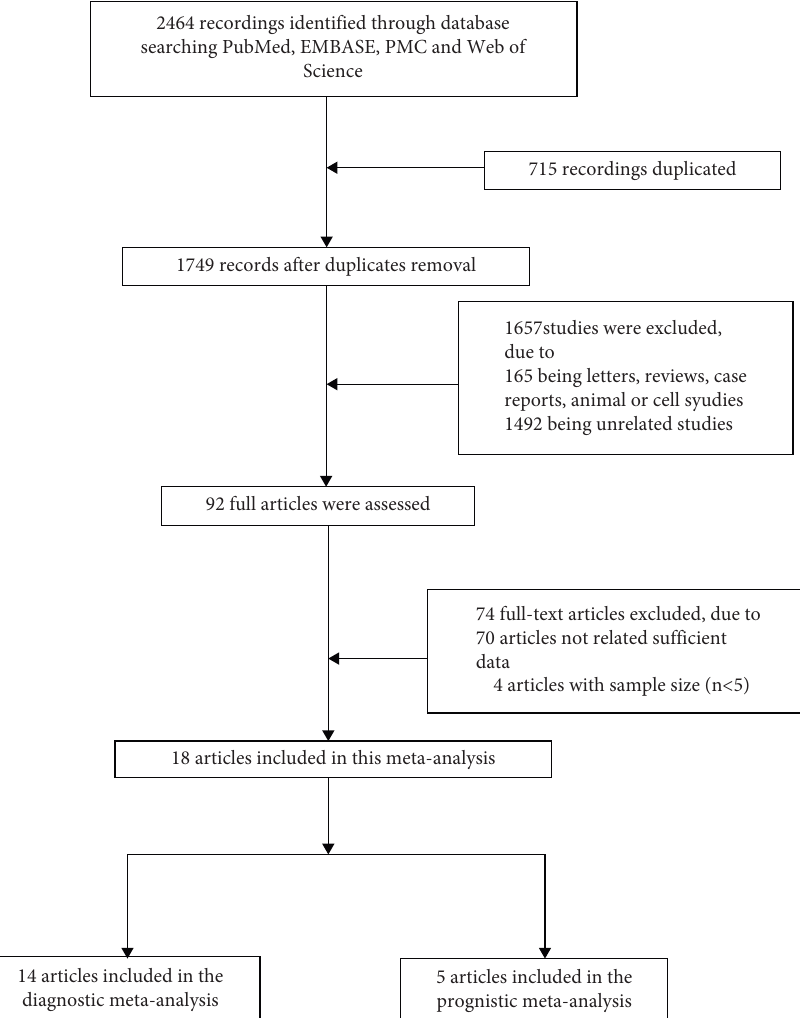
Figure 1: Flowchart of the study selection process in this